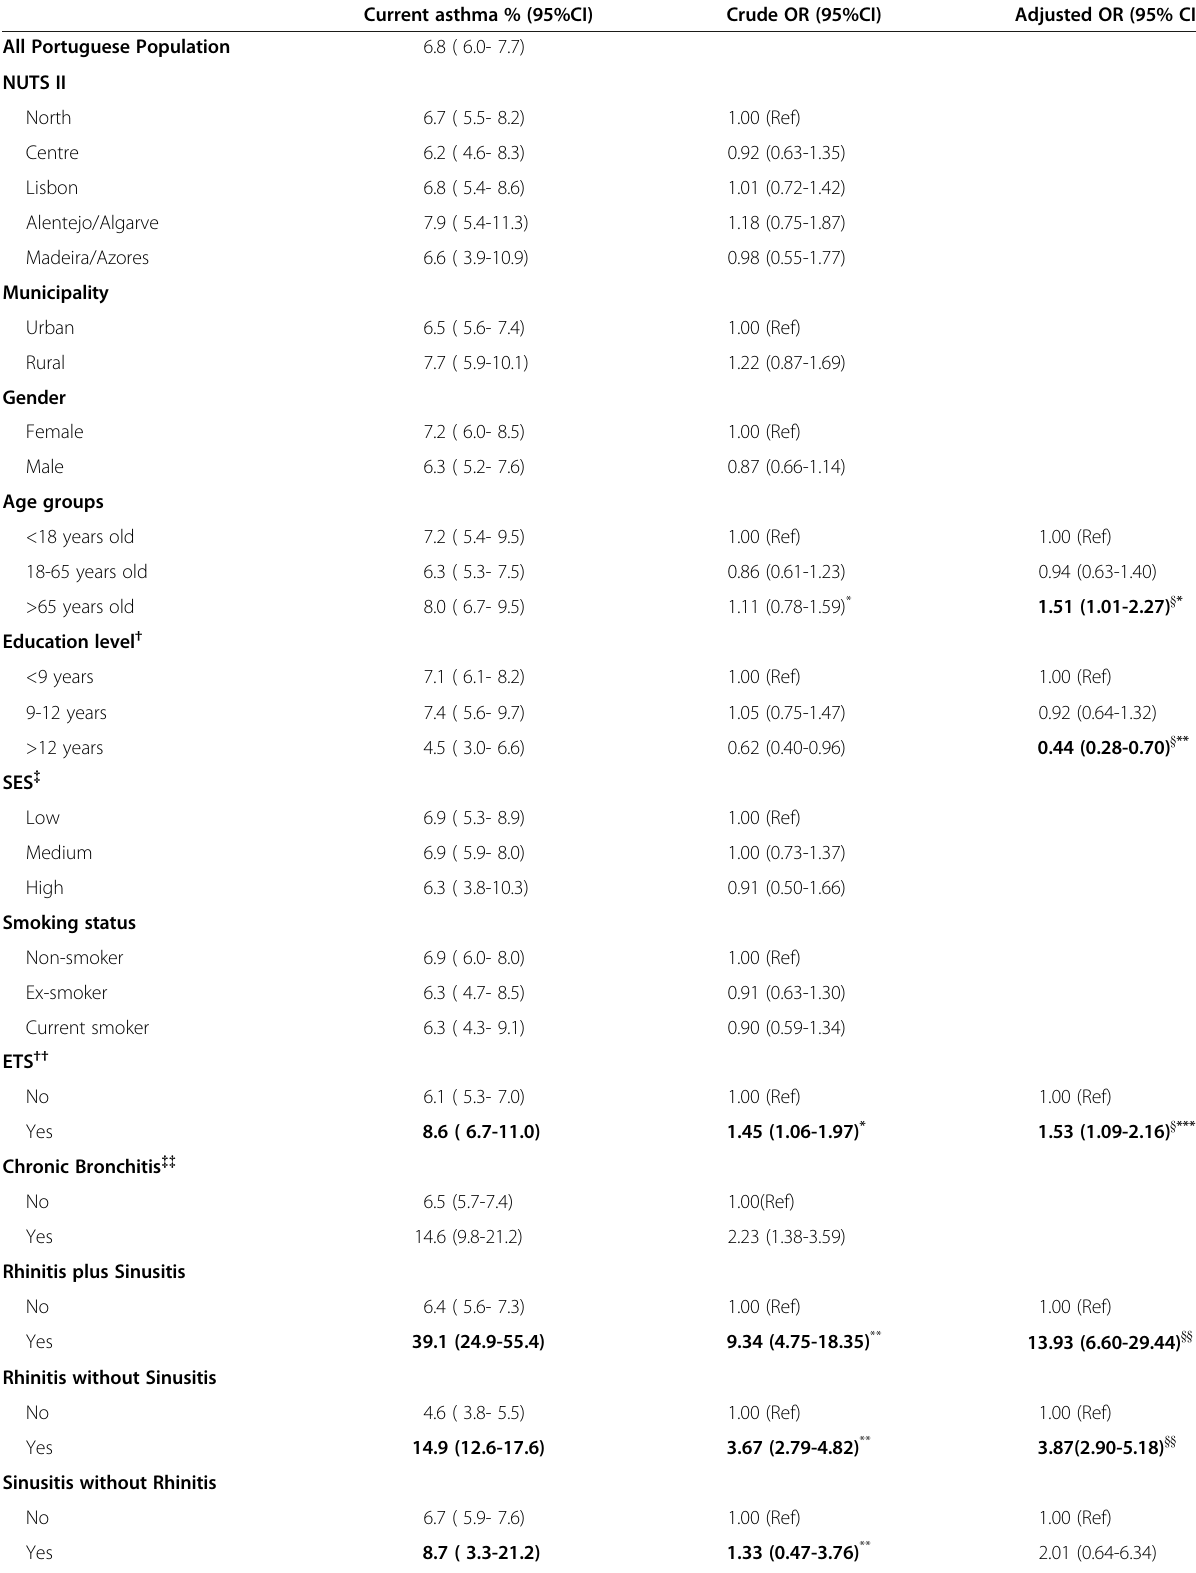
Table 2 Prevalence of ‘ Current asthma ’ and logistic regression models with crude and adjusted Odds Ratio